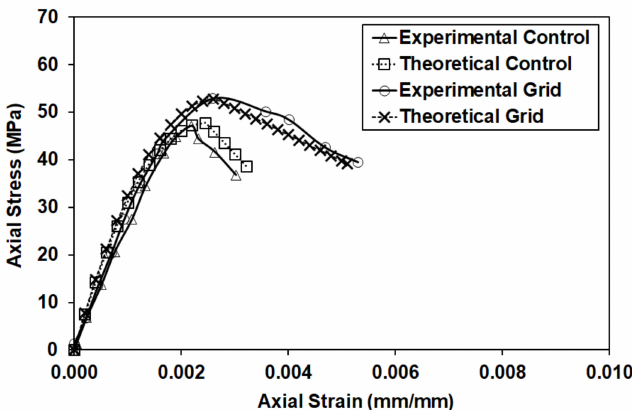
Figure 8. Average experimental and theoretical (confinement model) stress–strain curves for control and grid